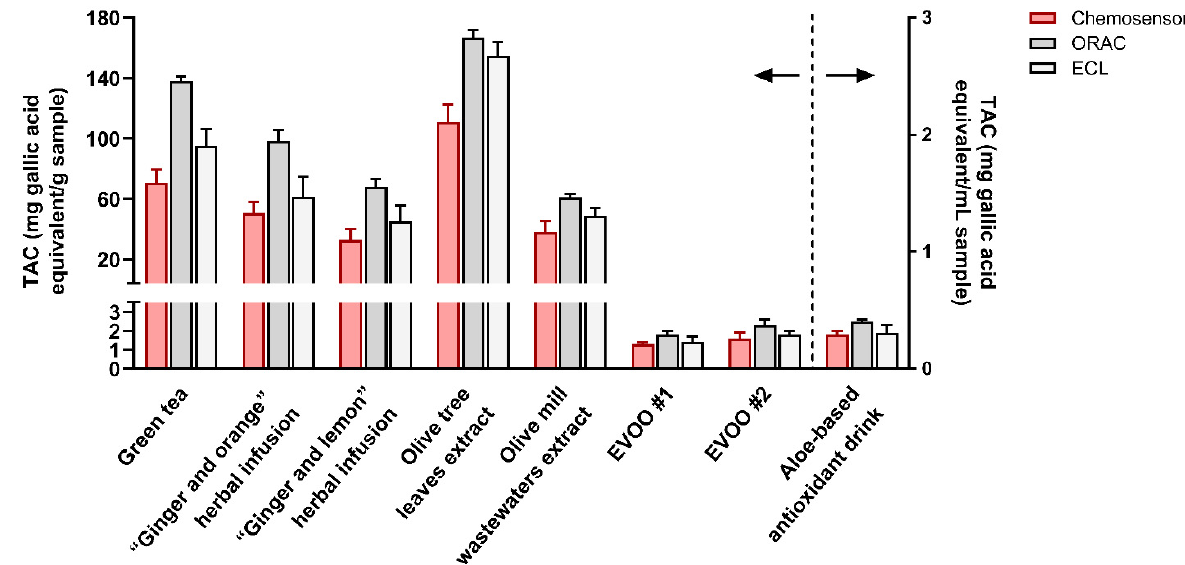
Figure 5. Results of TAC measurements performed in real samples with the AuNPs sensor and the ORAC and ECL antioxidant activity assays. Each data is the mean ± SD of three experiments.